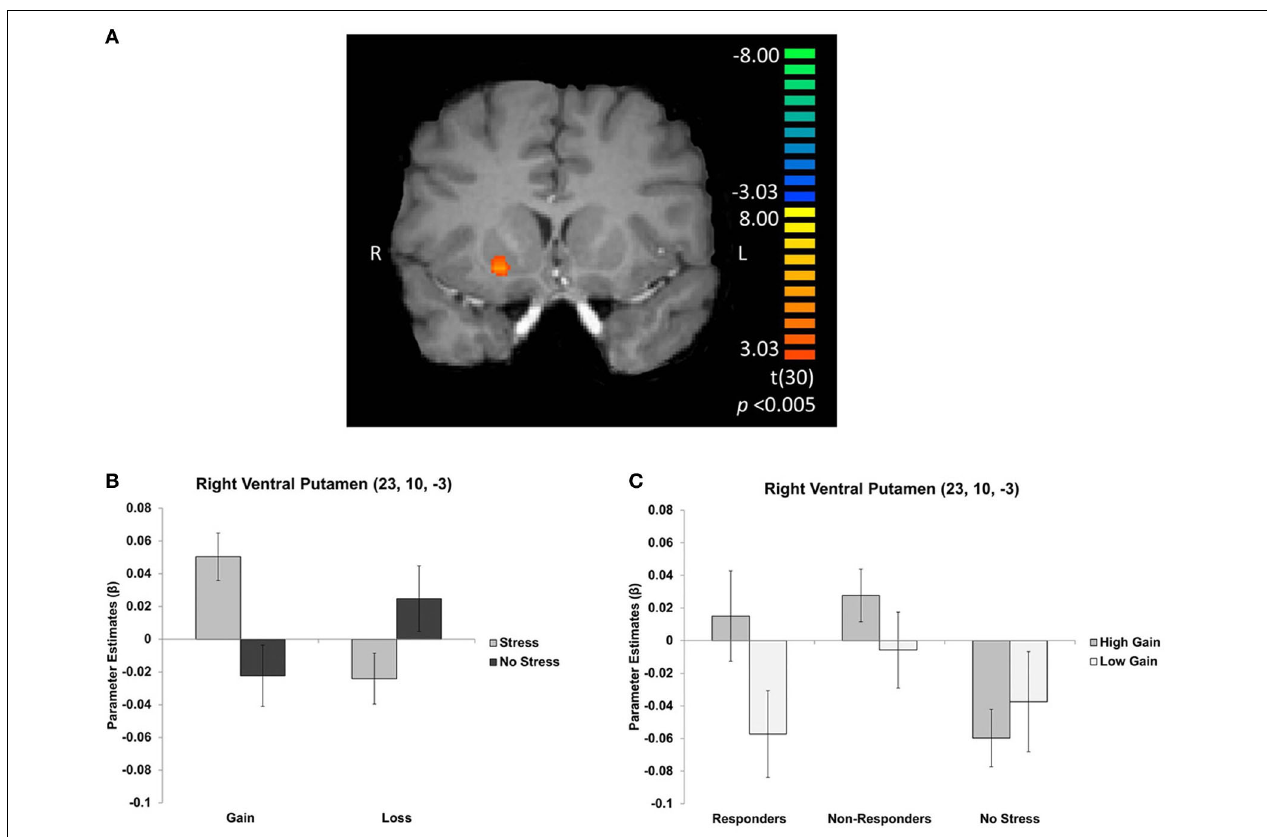
FIGURE 4 | (A) Right ventral putamen cluster resulting from an interaction contrast of [(high gain + low loss) − (low gain + high loss)], with the difference in BOLD resulting from this contrast computed along the between-subjects factor of stress group. Graphs depict mean parameter